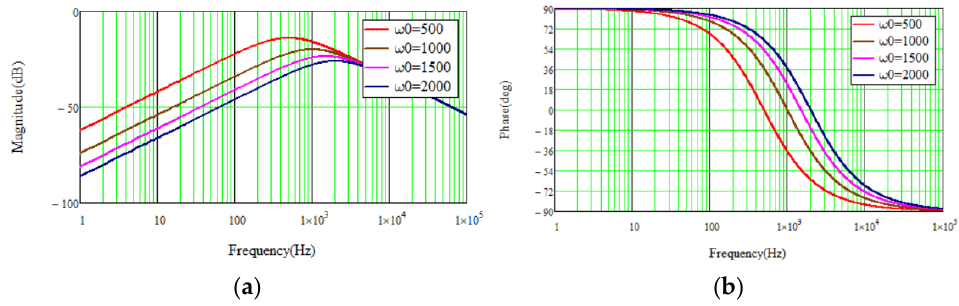
Figure 6. The magnitude and phase frequency curves of